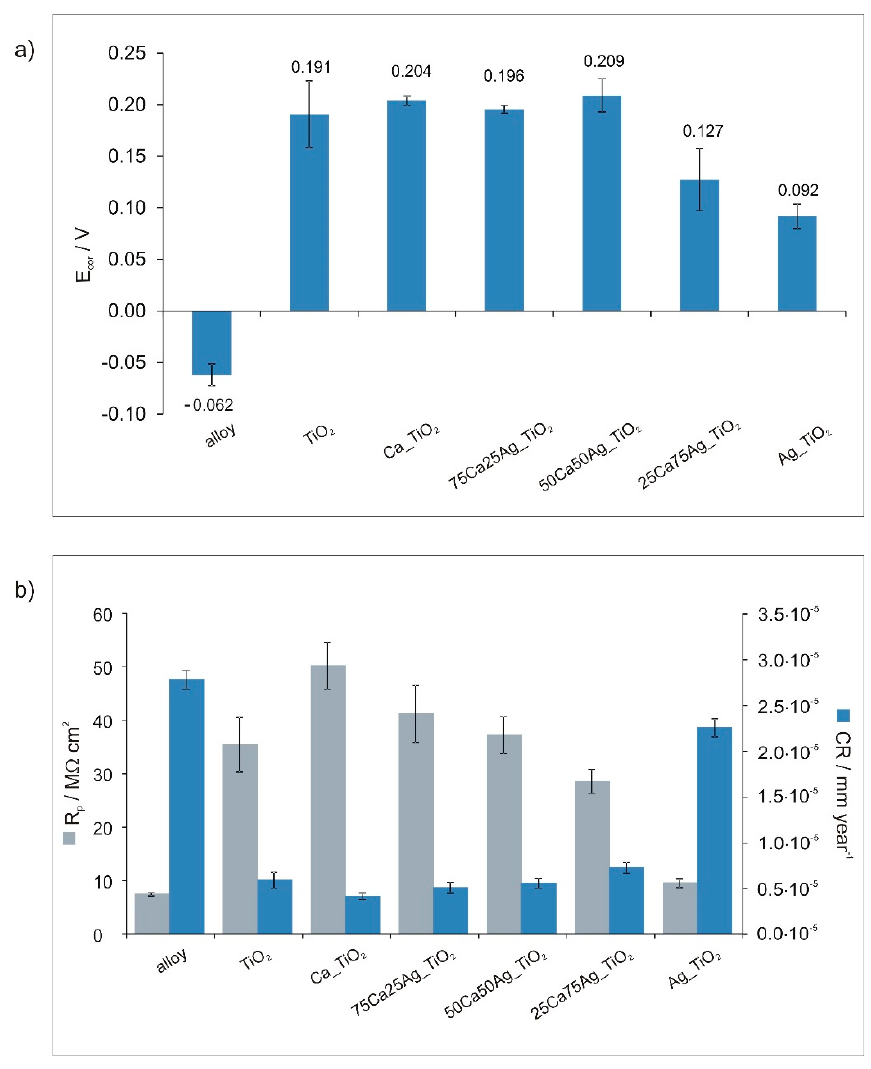
Figure 3. Values of ( a ) corrosion potential, E cor , ( b ) polarization resistance, R p , and corrosion rate, CR, determined for TiO 2 -based coatings doped with Ca and Ag ions in different molar ratios.